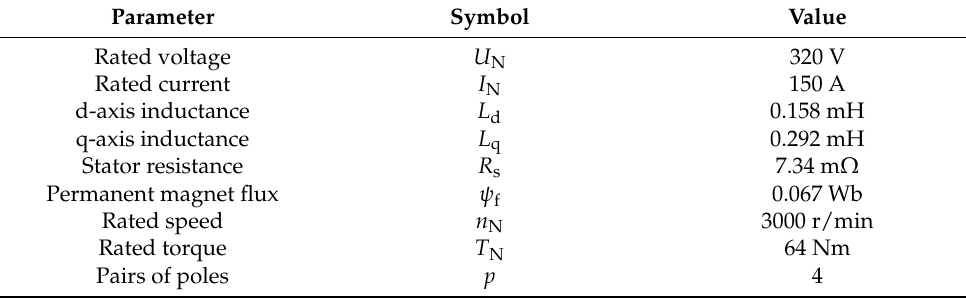
Table 1. Experimental prototype